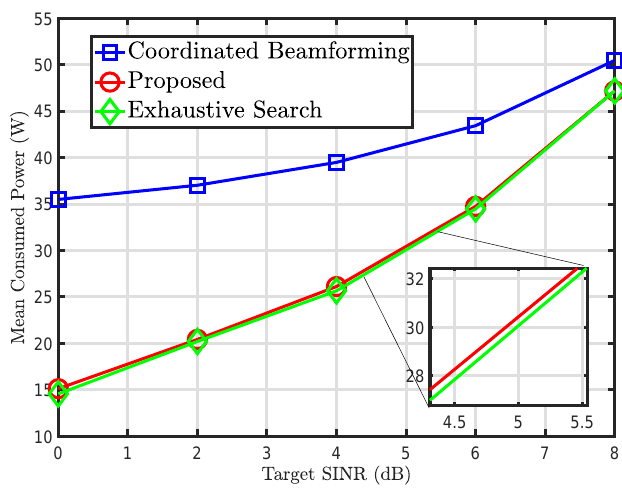
Figure 2. Mean power consumption versus target signal-to-intereference-and-noise ratio (SINR).